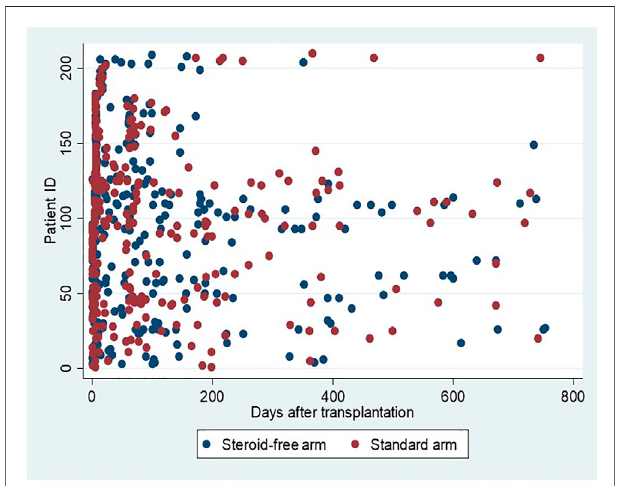
FIGURE 4 | Linear regression showing the relationship between MPA AUC measurements and body weight in all patients at baseline ( fi rst 2 weeks after transplantation). All patients received a dose of mycophenolate mofetil of 1 g twice